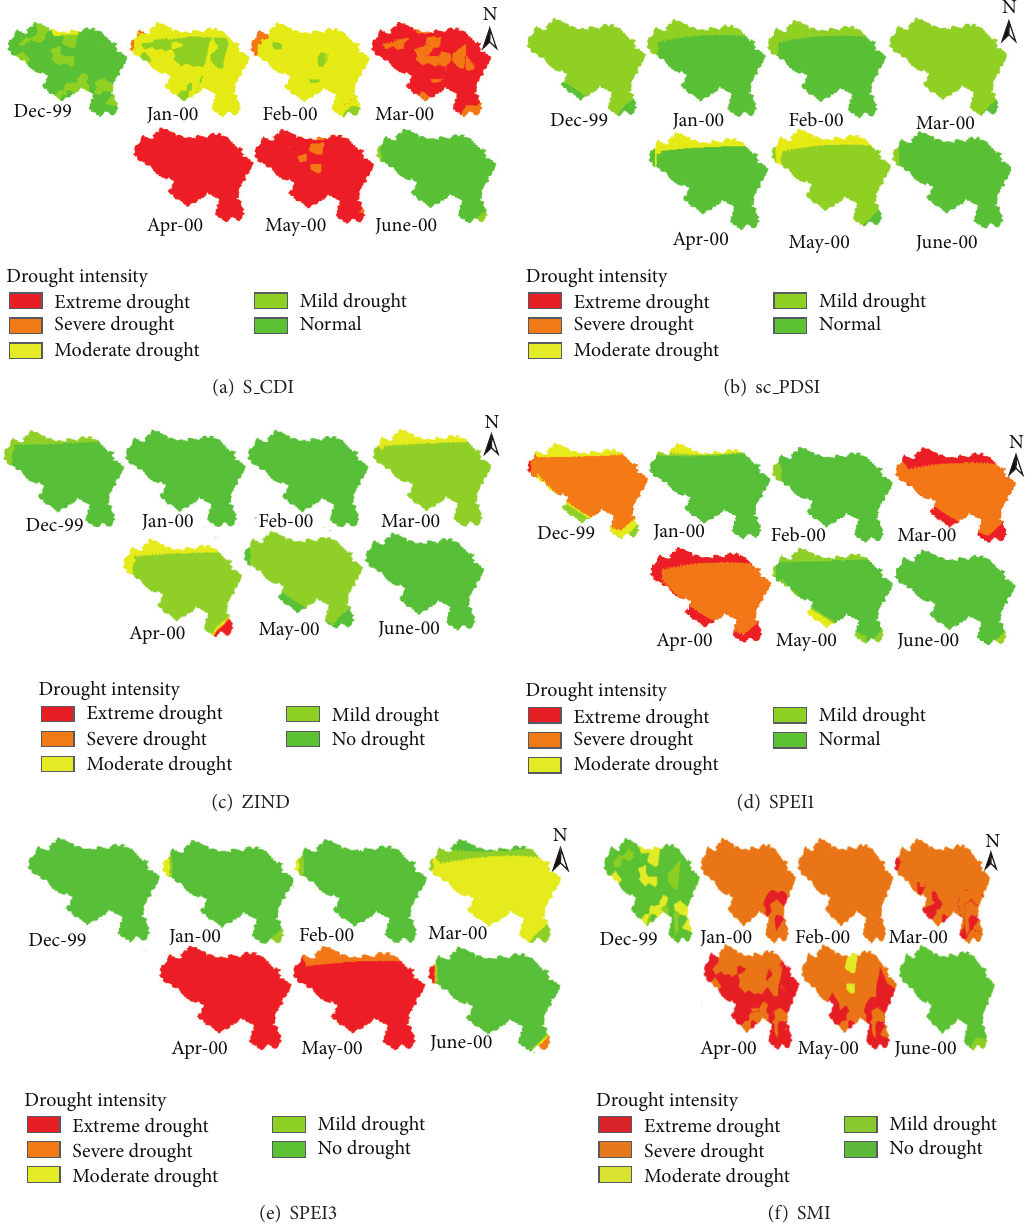
Figure 7: Dynamic spatial distributions of the S CDI and its components in the upper Huaihe River